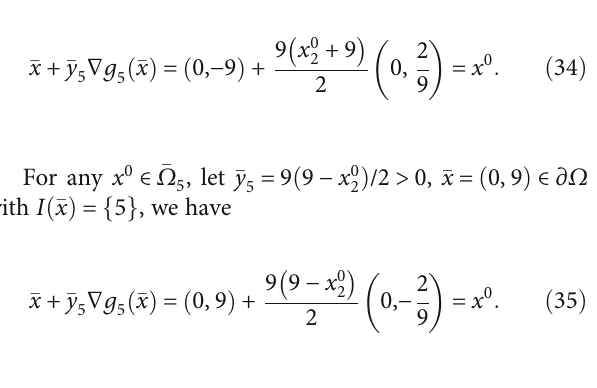
ffiffiffi p 2 /2 Þ > 0 coming from (cid:2) k